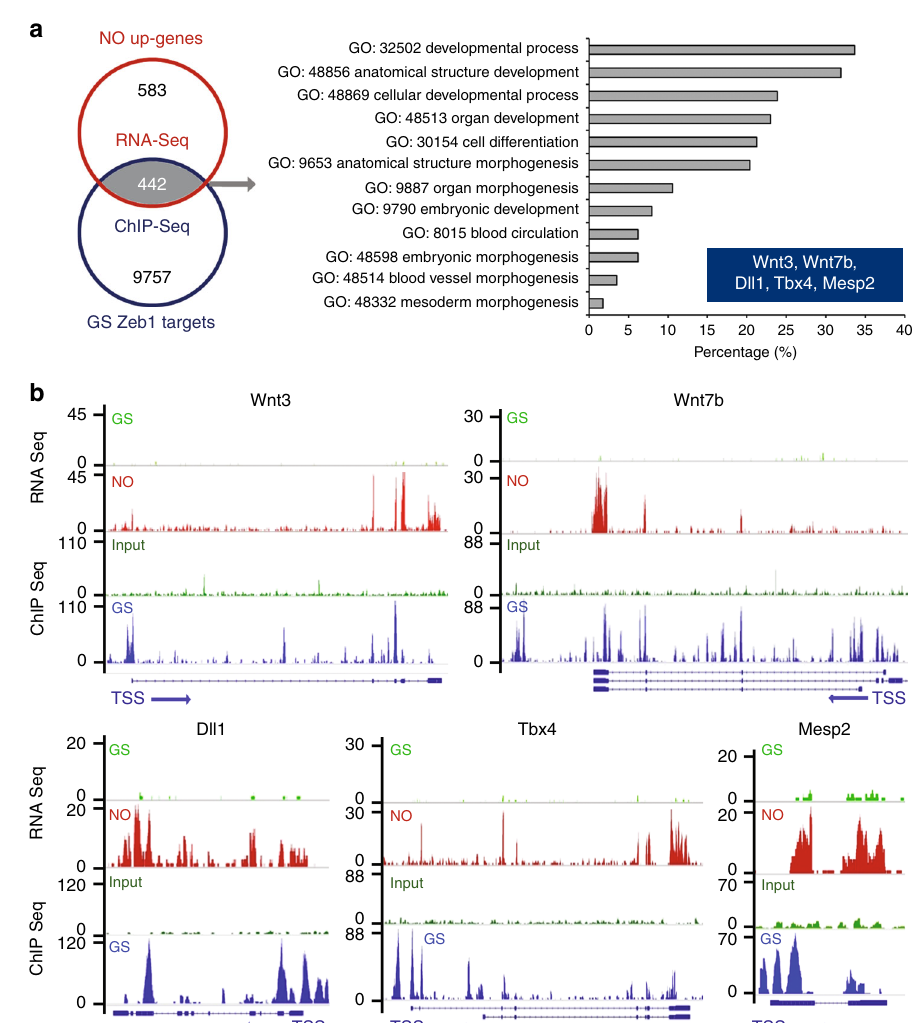
Fig. 2 Zeb1 binds chromatin at NO-responsive mesendodermal gene promoters. a Left panel: Venn diagram showing intersection between 1025 NO- upregulated genes (NO up-genes) identi fi ed by RNA Seq analysis (red circle) and 10199 gene promoters in which Zeb1 has been found associated with chromatin at TSS in cells cultured in GS condition (GS Zeb targets; blue circle). 442 common targets were found (gray area). Right panel: The gray arrow points to the result of gene ontology analysis based on the 442 common targets at the intersection between RNA-seq and ChIP-seq (left panel). The fi ve most represented genes, alias Mesp2, Wnt3, Wnt7b, Tbx4, and Dll1, listed in the blue colored inset. b Sashimi plots showing detailed peak positioning as determined by RNA-seq and ChIP-seq data for each selected mesendodermal gene. Speci fi cally, for each plot, RNA-seq data related to GS (light green) or NO (red) culture conditions and ChIP-seq data related to GS for input (dark green) and Zeb1 localization (blue) were